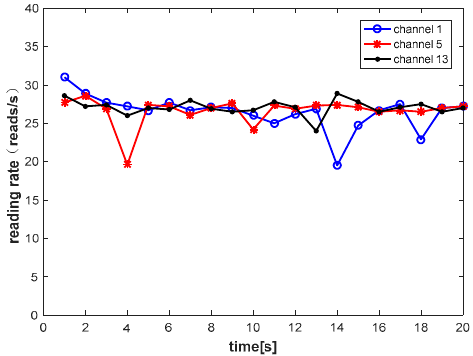
Figure 2. A typical example of channel stability.